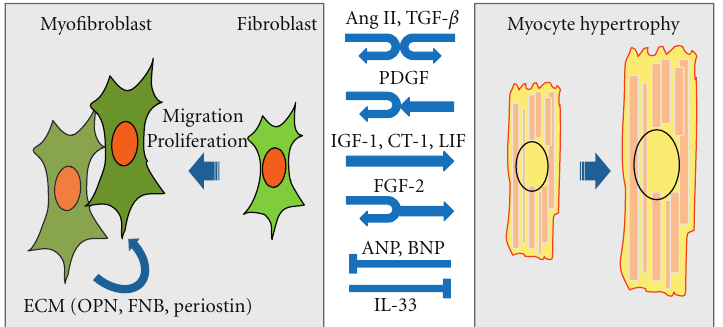
Figure 2: Reciprocal interactions between fibroblasts and cardiomyocytes. Many growth factors and cytokines have been shown to act in autocrine and/or paracrine fashion to induce hypertrophic responses in cardiomyocytes and activate fibroblasts. This scheme depicts only some of the factors identified. Ang II: angiotensin II; TGF- β : transforming growth factor- β ; PDGF: platelet-derived growth factors;